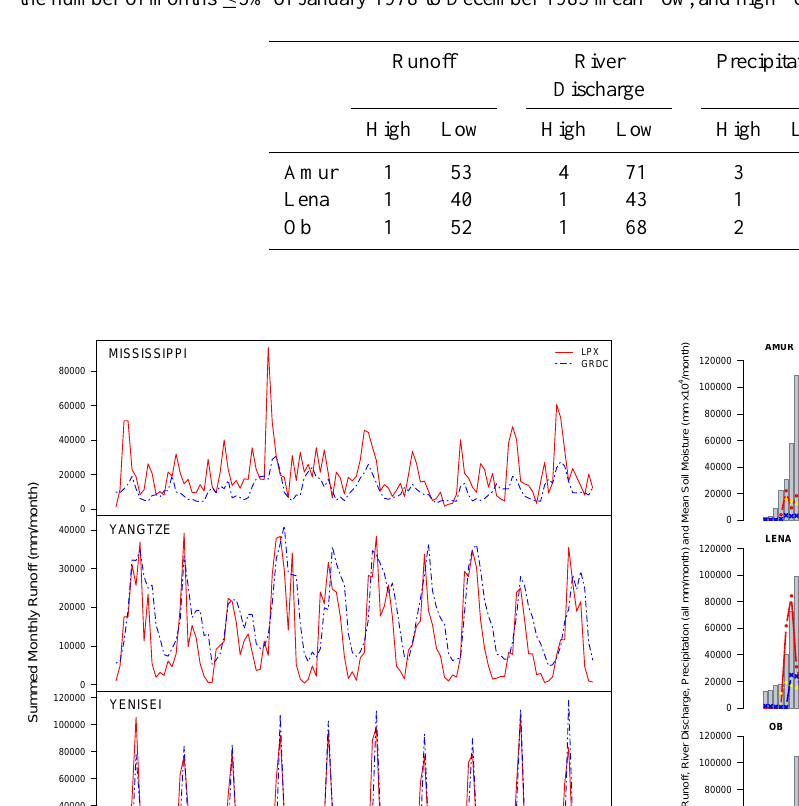
Table 1. Monthly high and low flow frequencies of summed monthly LPX runoff, GRDC river discharge, CRU TS 3.0 precipitation and mean GSMDB soil moisture for three Russian catchments between January 1978 and December 1985. Low flow frequency is determined as the number of months ≤ 5% of January 1978 to December 1985 mean flow, and high flow frequency as the number of months ≥ 95%.